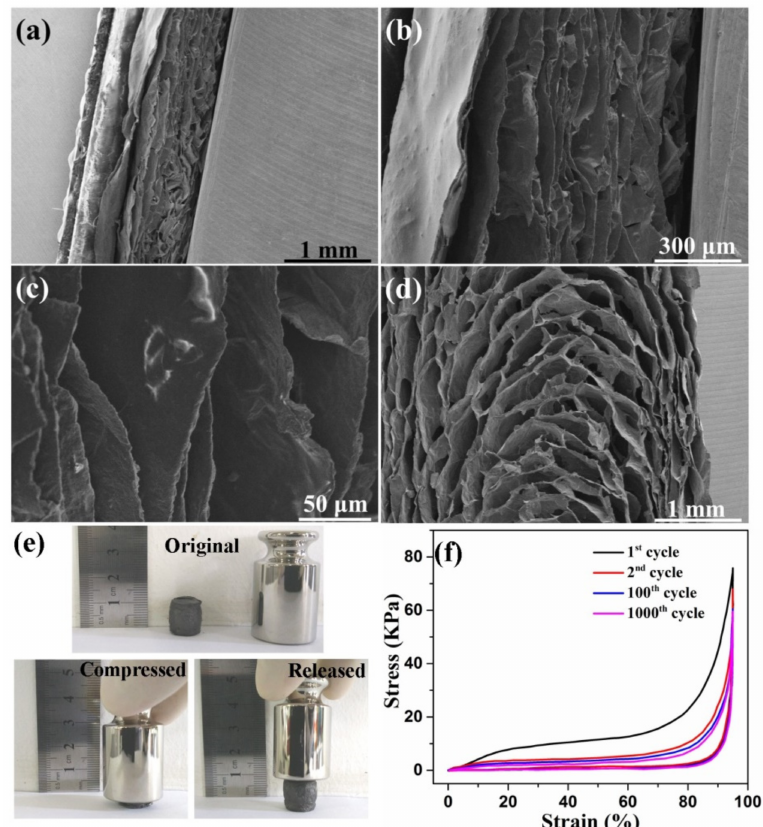
Figure 6. The cross-section SEM images of g-rGO/PI aerogel ( a – c ) at compression status and ( d ) at release status; ( e ) Digital photographs of the compress/recovery process of g-rGO/PI aerogel; ( f ) Stress/strain curves of the 1st, 2nd, 100th and 1000th cycles of g-rGO/PI